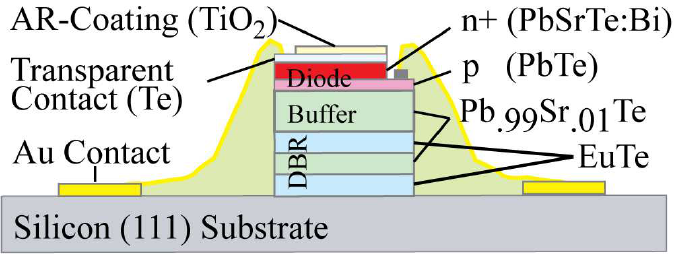
Figure 9: Detailed schematic representation of the detector part layout as shown in the lower part of Figure 1, including the Distributed Bragg Reflector (DBR), the buffer layer and the photosensitive